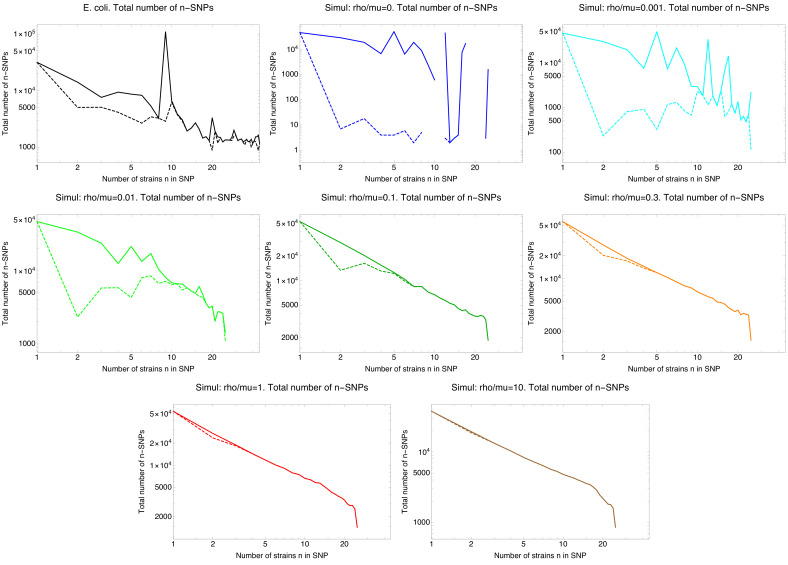
SNP frequency spectra.Total number of occurrences of n-SNPs, that is SNPs shared by n strains (vertical axes) as a function of n (horizontal axes) for the E. coli data (top left panel) and all simulated data with different recombination rates, where the ratio of recombination to mutation rate ρ/μ is indicated above each panel. The solid lines correspond to all n-SNPs in the 5% homoplasy-corrected alignment, whereas for the dashed lines all n-SNPs corresponding to branches in the core tree have been removed. Note that all axes are shown on logarithmic scales and for high recombination rates ρ/μ≥0.1, the n-SNP frequencies are approximately proportional to 1/n.